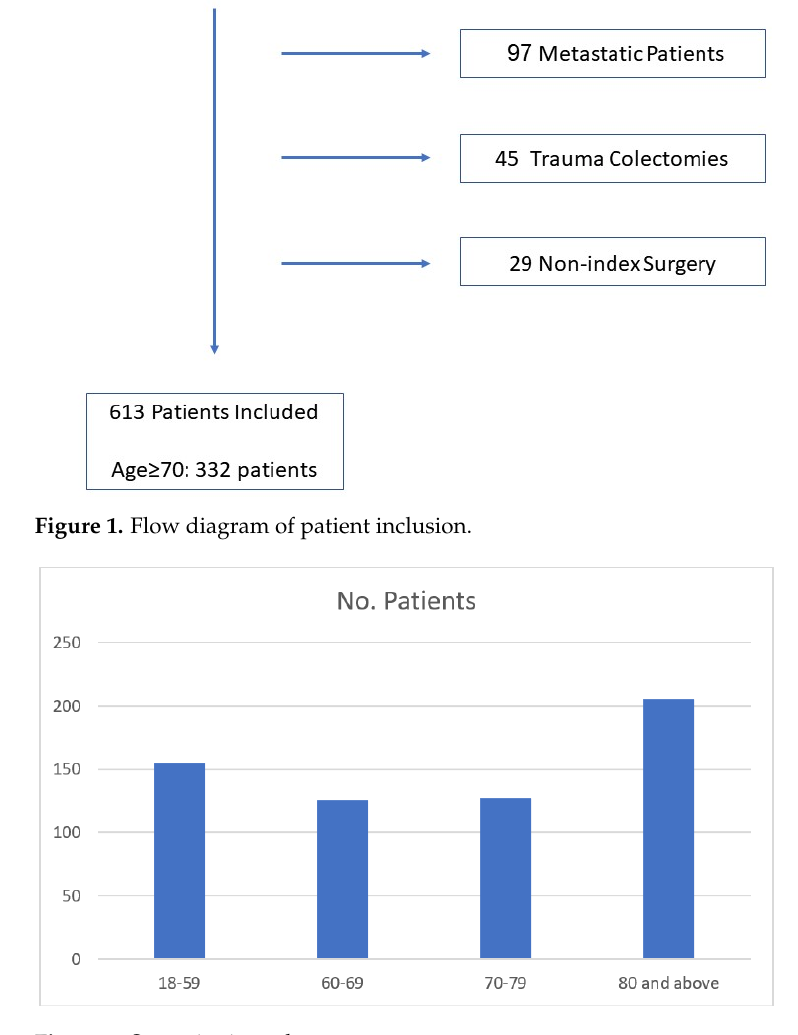
Figure 3. 30-day mortality rates in each age group. Figure 4. Overall Kaplan-Meier survival curve.